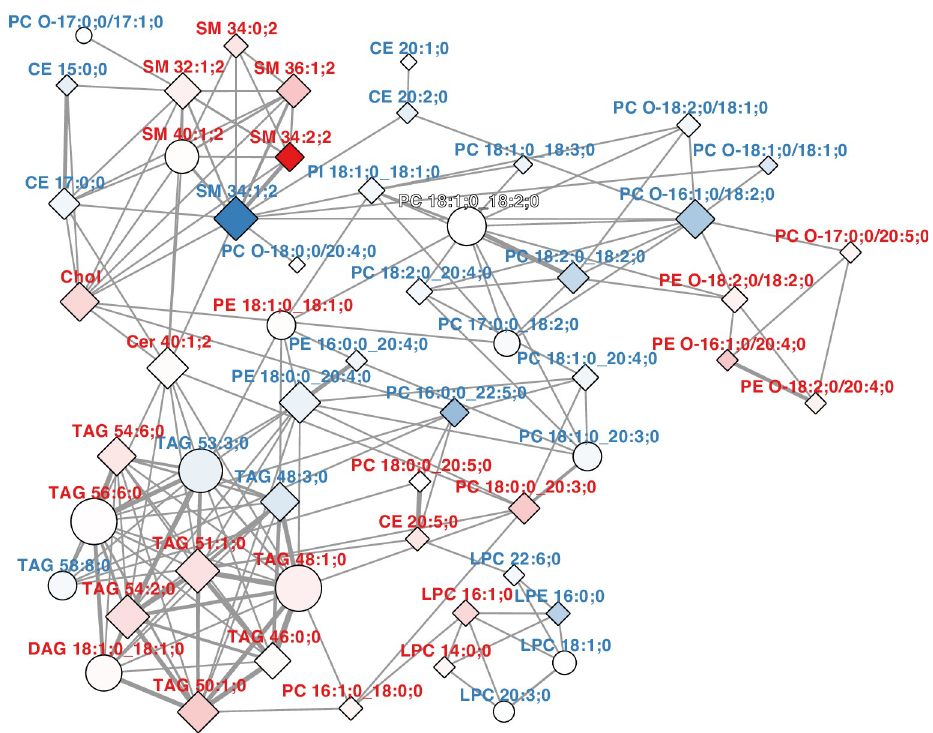
Fig 2. Lasso model predictors. Pearson correlation network of the lipid predictors of the best Lasso model predicting BFP with the lowest MAE and the model at 1 standard error distance (as in S4 Fig). A network cutoff of | r | > 0.5 was used. Nodes are shaped as diamonds for predictors in both models and as circles if the predictor appears only in one model. Nodes are filled according to the β -coefficients of the model with the lowest MAE, with a gradient from blue to white for negative β -coefficients and a gradient from white to red for positive β -coefficients. Lipid labels are colored blue for negative β -coefficients and red for positive β -coefficients. Edge weights indicates the value of the correlation coefficient ( r ). All values of r are positive in this network. The data are reported in S6 Table, and β -coefficients are plotted in S5 Fig. BFP, body fat percentage; CE, cholesteryl ester; Chol, cholesterol; DAG, diacylglyceride; LPC, lysophosphatidylcholine; MAE, mean absolute error; PC, phosphatidylcholine; PE, phosphatidylethanolamine; PI, phosphatidylinositol; SM, sphingomyelin; TAG, triacylglyceride.